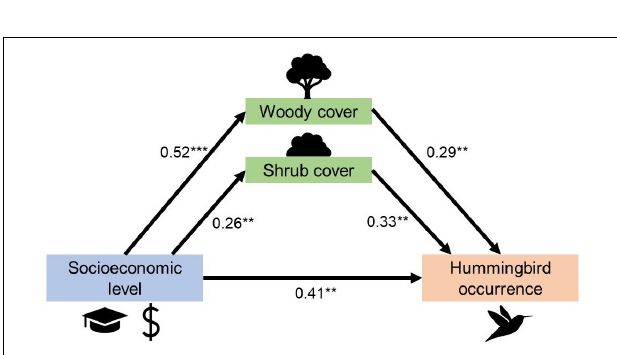
FIGURE 4 | Results from path analysis evidences a partial mediation of woody and shrub cover on the observed relationship between neighborhood socioeconomic level and the Green-backed Firecrown hummingbird occurrence. Arrows represent a regression (causal) relationship between independent and dependent variables. The numbers on the arrows are standardized regression coefficients that indicate the strength and direction of the effects between variables. Statistical significance: ** P < 0.01, *** P < 0.001. The proportion of variance of the Green-backed Firecrown hummingbird occurrence explained by the predictors: R 2 =